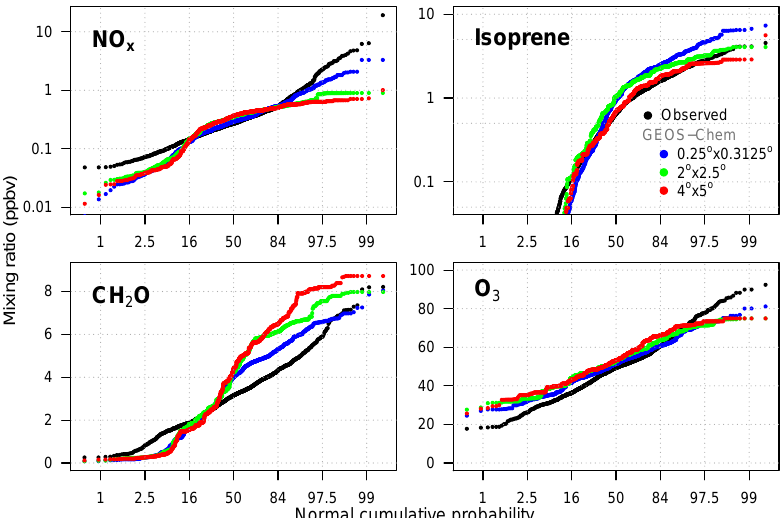
Figure 4. Cumulative probability distribution functions (CDFs) of NO x , isoprene, formaldehyde (CH 2 O), and ozone (O 3 ) concentrations in the Southeast US mixed layer during the SEAC 4 RS aircraft campaign. Observations are compared to GEOS-Chem model values at different resolutions (0.25 ◦ × 0.3125 ◦ , 2 ◦ × 2.5 ◦ , 4 ◦ × 5 ◦ ) sampled along the flight tracks over the Southeast US domain of Fig. 1. The x axis is a normal probability scale such that a normal distribution (formaldehyde, ozone) or lognormal distribution (NO x , isoprene) would plot on a straight